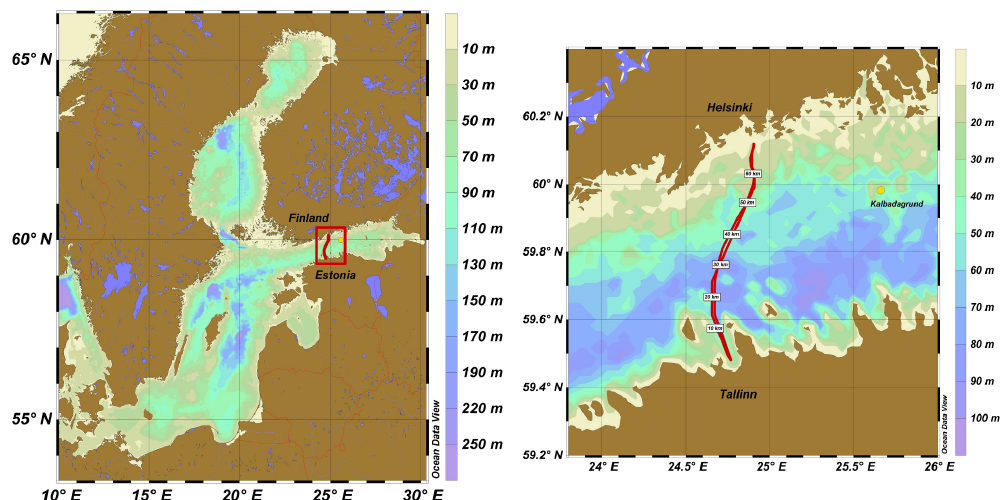
Figure 1. Map of the Baltic Sea (a) and the study area (b) with the Ferrybox transect and Kalbadagrund meteorological station. Maps are made using Ocean Data View software (Schlitzer,